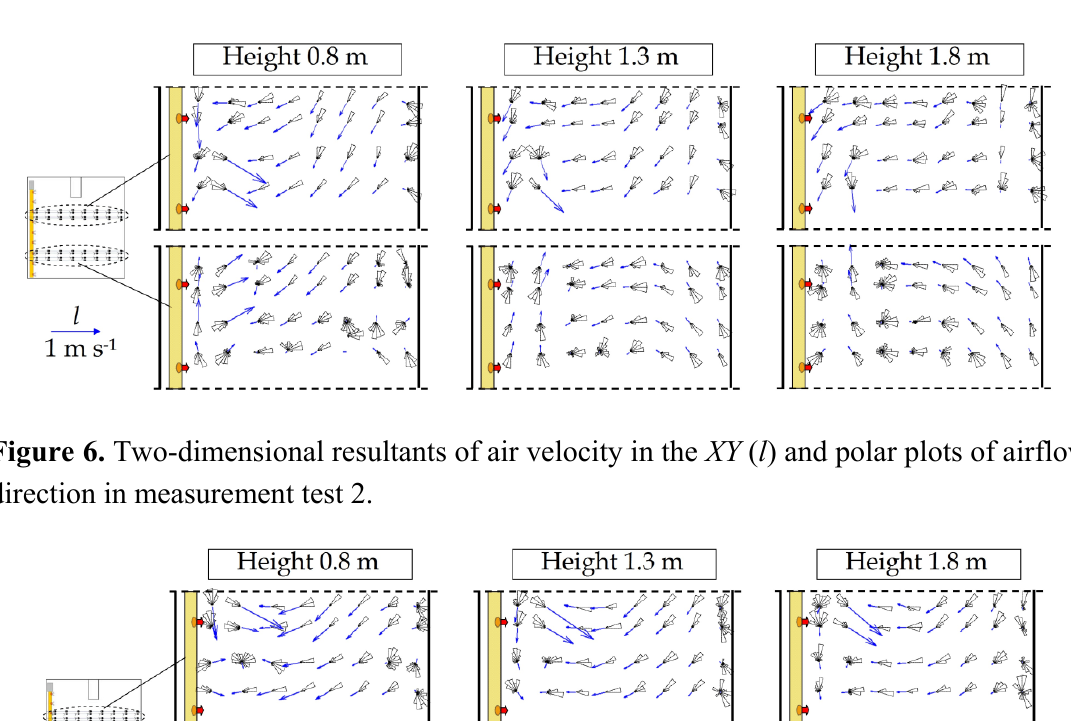
Figure 5. Two-dimensional resultants of air velocity in the XY plane ( l ) and polar plots of airflow direction in measurement test 1.